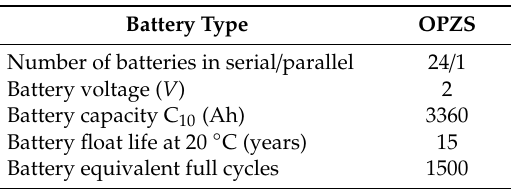
Table 3. Batteries data.